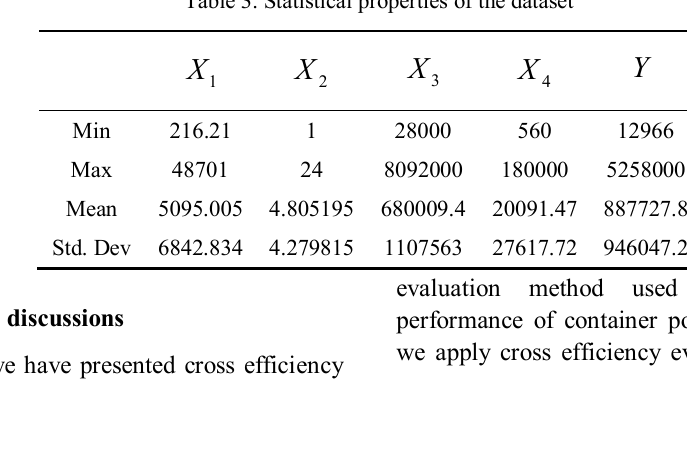
Table 3. Statistical properties of the